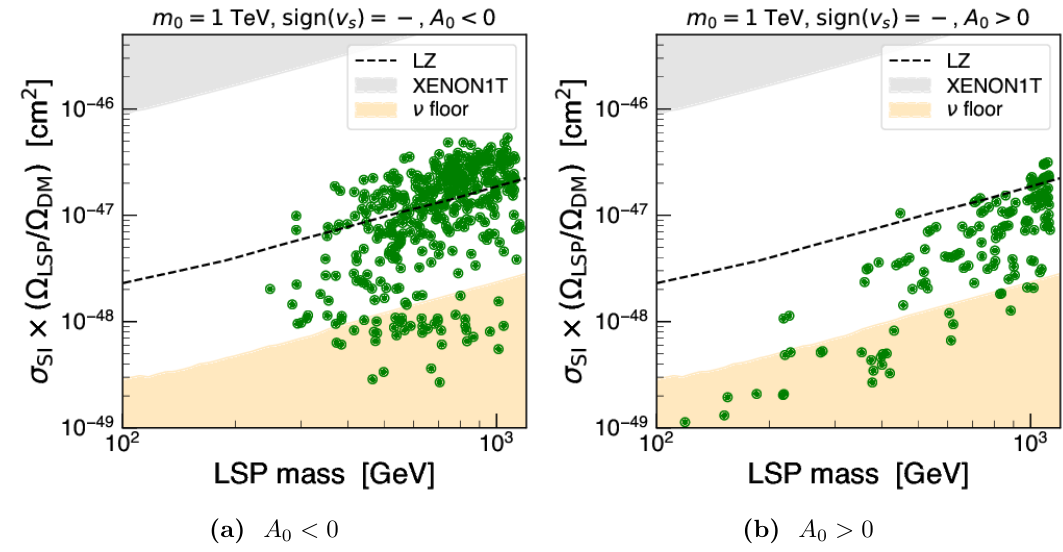
Figure 5. Scatter plots of the spin-independent LSP-proton scattering cross sections against the LSP mass. Here, the gray shaded region, black dashed line, and the orange shaded region represent the XENON1T bound [118], the expected sensitivity of the LZ experiment [119], and the neutrino (cid:13)oor [120],